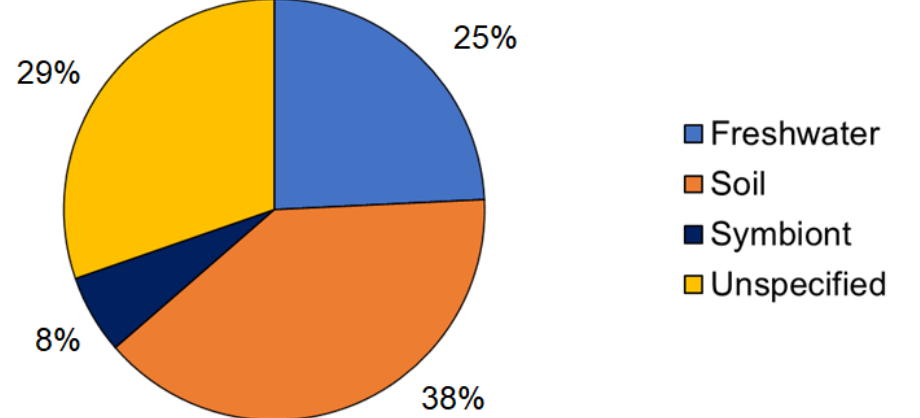
Figure 3. Main isolation sources of Streptomyces strains capable of biodegradation of synthetic